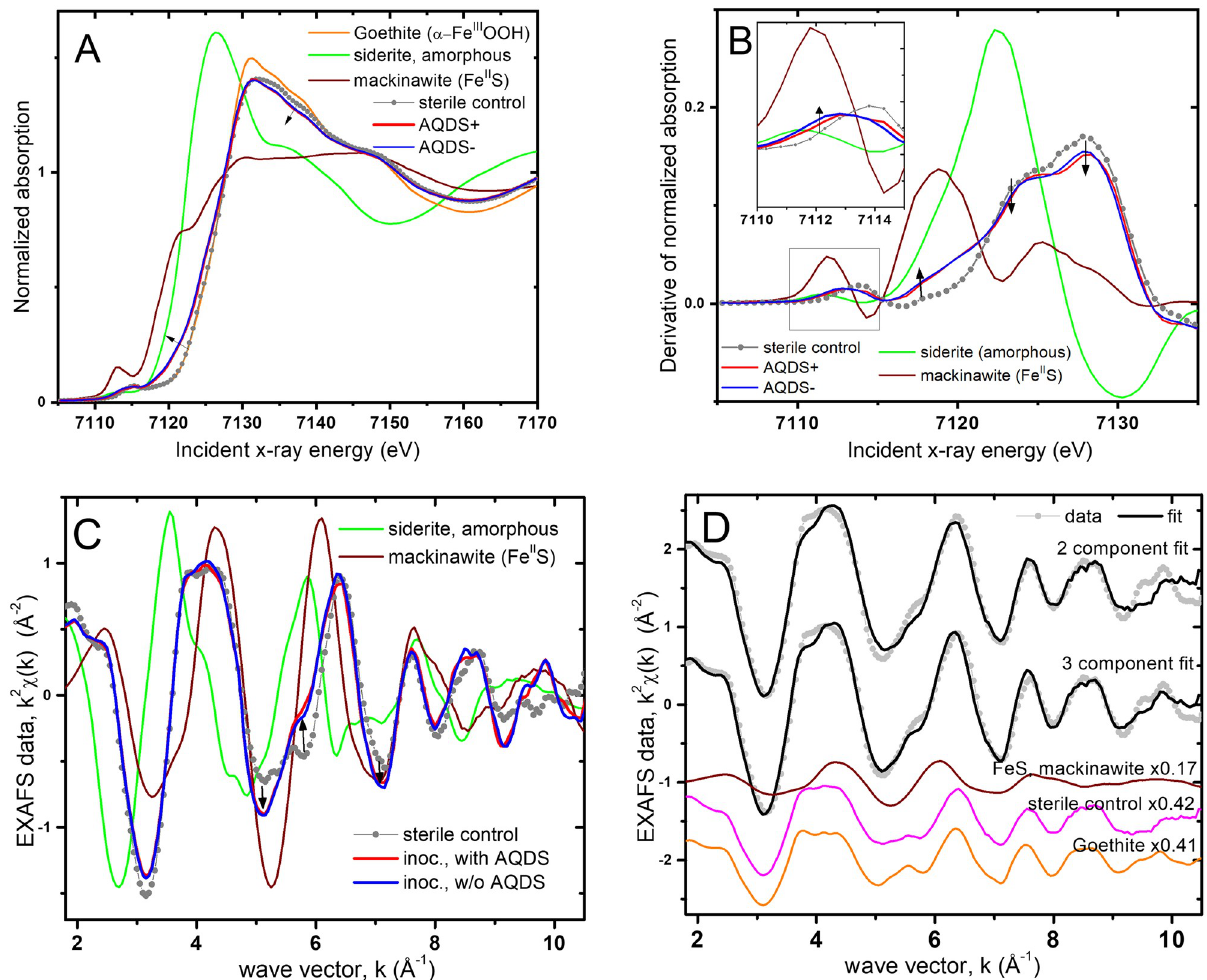
Fig 2. Fe XAFS analysis of bioreactor solids. Comparisons of XANES data from the bioreactors (with (AQDS+) and without AQDS (AQDS–)) to the sterile control and Fe II /Fe III standards. The lines corresponding to the AQDS+ and AQDS- bioreactors (red and blue) nearly overlap. A) XANES data. Arrows indicate the spectral shifts from Fe III to Fe II standards. B) Derivative of the spectra in A. Arrows point in the direction of the spectral shifts towards the Fe II S standard. Inset shows detail in the pre-edge region (box). C) EXAFS data. Arrows point in the direction of spectral shifts towards the Fe II S standard. D) LC fit of the data from the inoculated AQDS–bioreactors using two and three endmembers (the data for AQDS+ and AQDS − bioreactors are the same within measurement uncertainty). The weighted components in the best fit are offset for clarity. Mackinawite and the sterile control were the best fit components in both 2- and 3-component LC models. The fit range is 2-10 Å − 1 and the refined proportions are summarized in S1 Table in S1